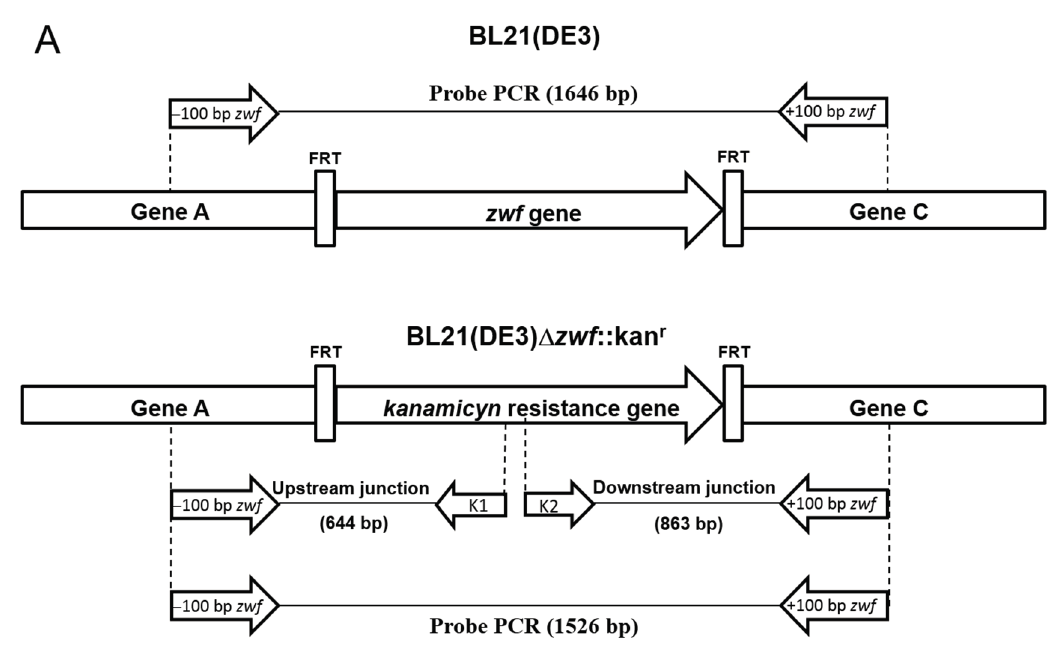
Figure 1. Construction of E. coli BL21(DE3) Δ zwf ::kan r mutant. ( A ) Representation of gene arrangement in E . coli BL21(DE3) Δ zwf ::kan r generated by homologous